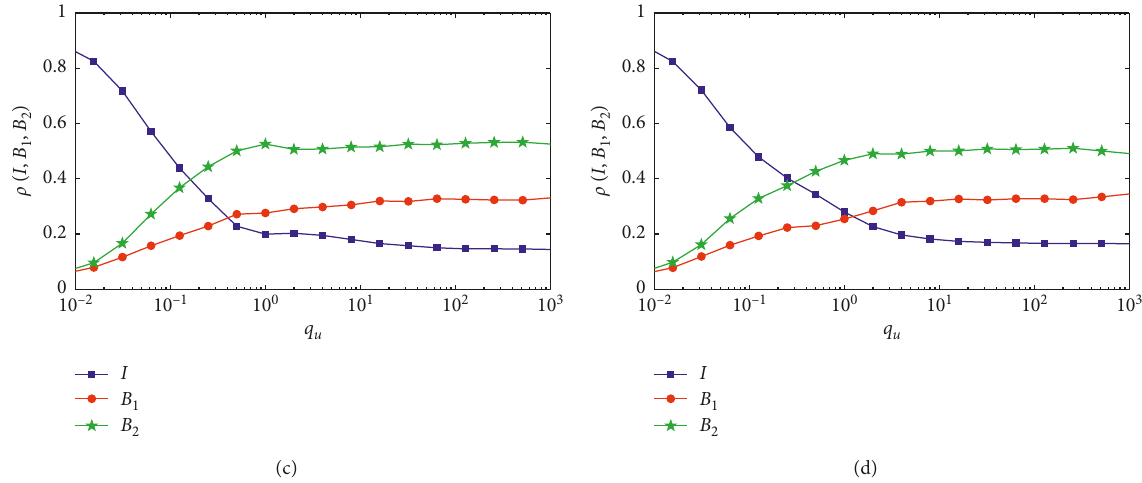
Figure 5: The values of ρ and ε � 0.1. (a) Hamsterster ; (b) Simmons81 ; (c) Oberlin44 ; (d) Bowdoin47